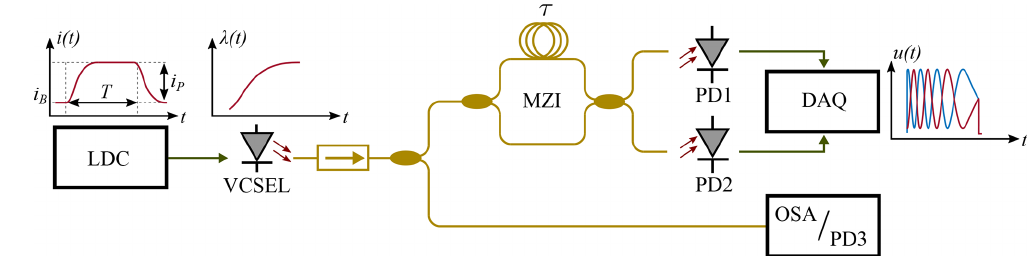
Figure 2. Measurement